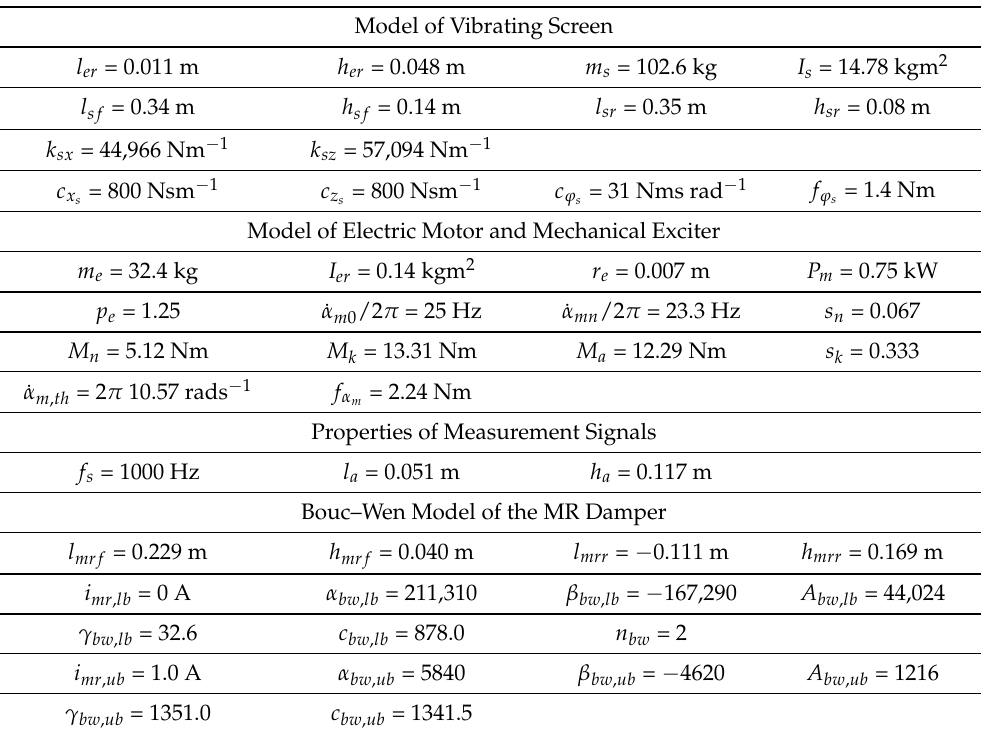
Table 1. Estimated parameters of the simulator of the vibrating screen. Model of Vibrating